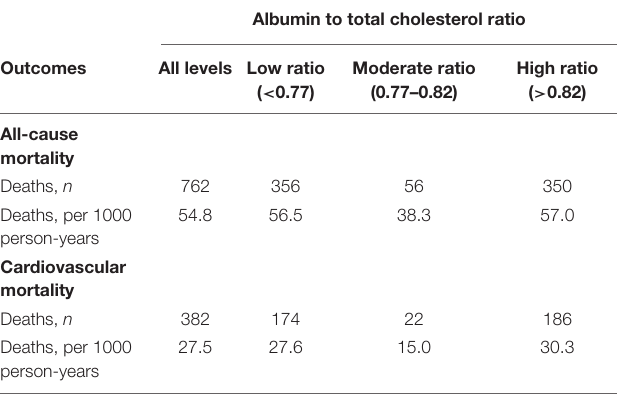
TABLE 2 | Incidence rate of death according to albumin to total cholesterol ratio. Albumin to total cholesterol ratio